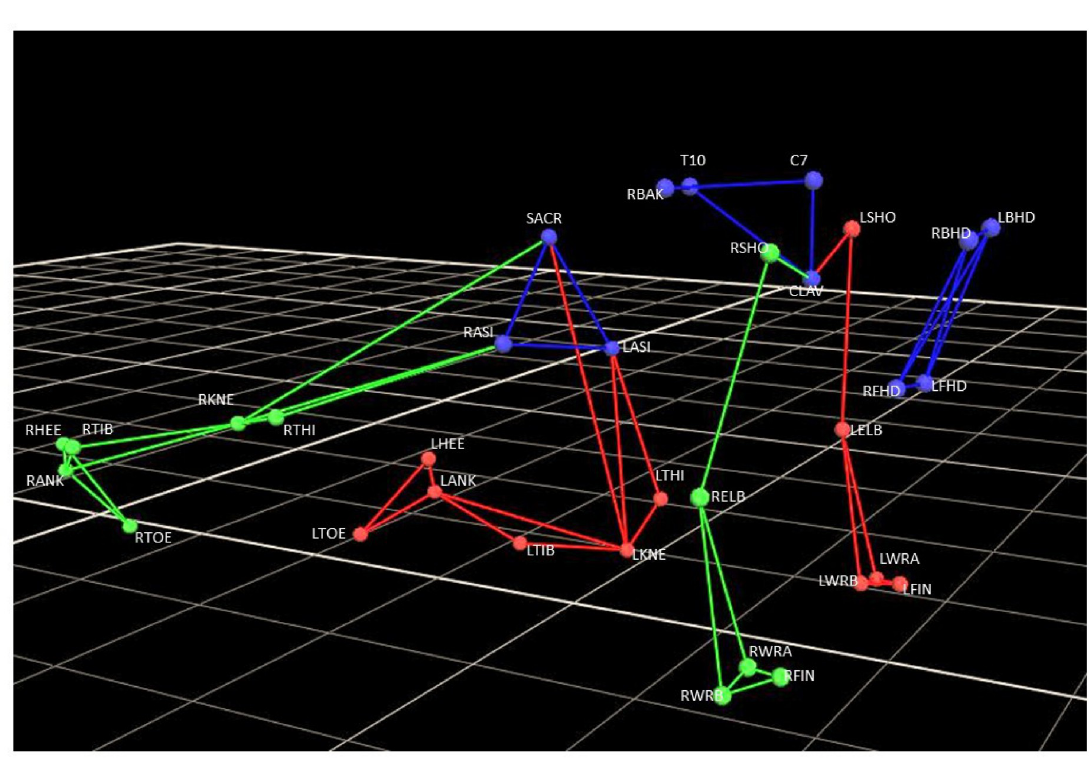
Fig 1. Plug-in Gait marker set-up during Cat exercise in novice performer. LFHD = Left front head; RFHD = Right front head; LBHD = Left back head; RBHD = Right back head; C7 = 7th Cervical Vertebrae (spinous process); T10 = 10th Thoracic Vertebrae (spinous process); CLAV = Clavicle (jugular notch); STRN = Sternum (xiphoid process); LASI = Left anterior superior iliac spine; RASI = Right anterior superior iliac spine; SACR = Sacral wand marker. All next markers are placed symmetrically. However, in this legend only the left side markers are named. LSHO = Left shoulder marker (acromio-clavicular joint); LELB = Left elbow (lateral epicondyle); LWRA = Left wrist marker A (styloid process radius); LWRB = Left wrist marker B (styloid process ulna); LFIN = Left fingers (dorsal side of second distal metacarpal head); LTHI = Left thigh; LKNE = Left knee (lateral epicondyle); LTIB = Left tibial wall marker; LANK = Left ankle (lateral malleolus); LHEE = Left heel (calcaneous); LTOE = Left toe (dorsal side of second distal metatarsal head).